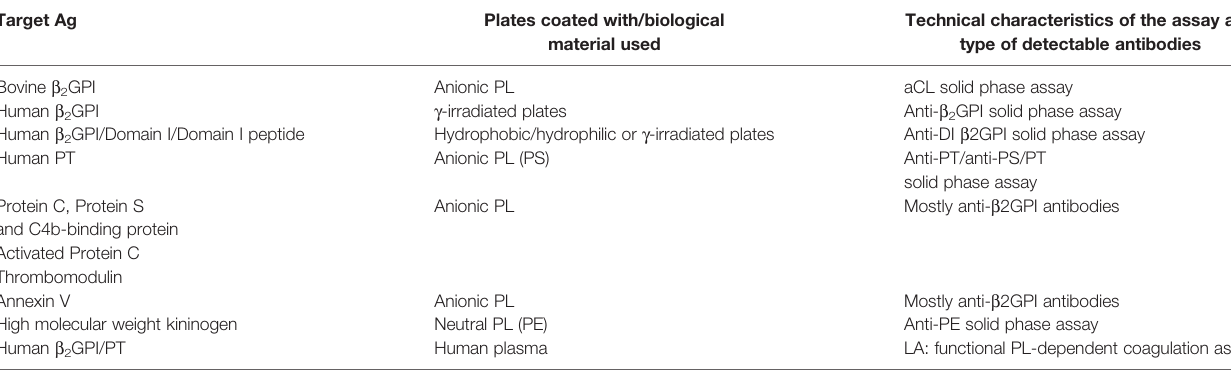
TABLE 1 | Classi fi cation and nonclassi fi cation laboratory aPL assays. Target Ag Plates coated with/biological